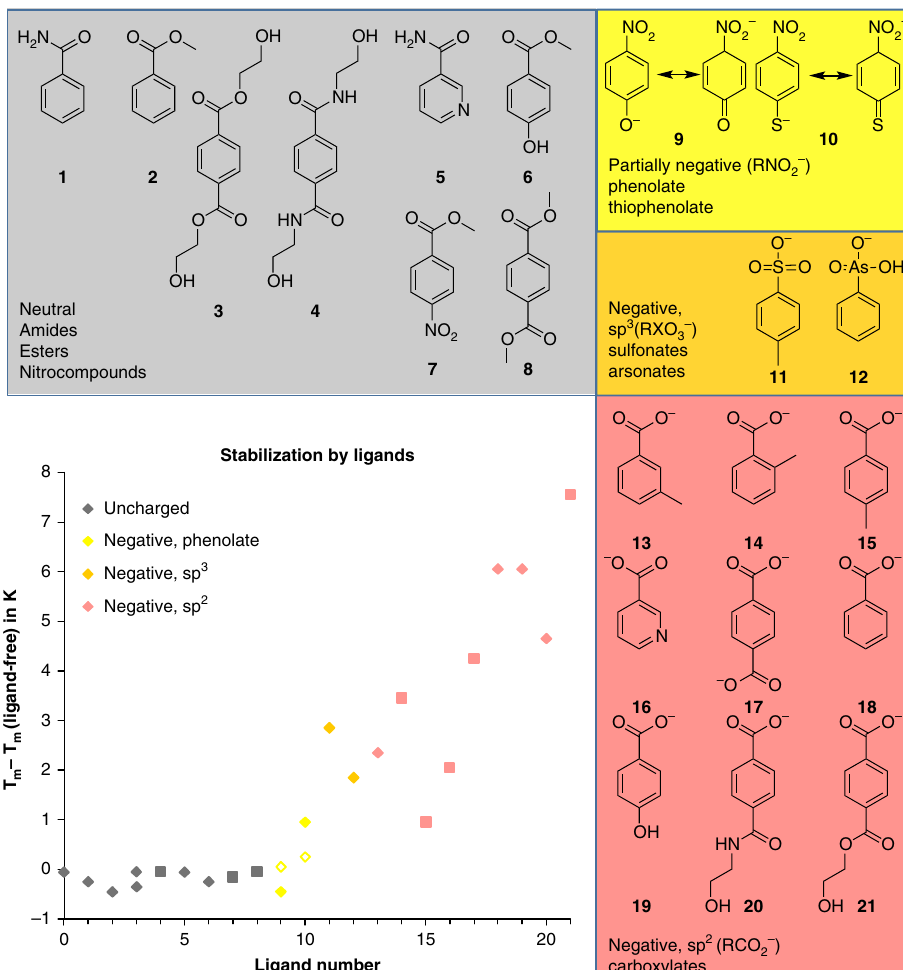
Fig. 3 Differential scanning fl uorimetry of MHETase with various ligands. Stabilization of MHETase wild type as measured by an increase in the melting temperature ( T m ) compared to the ligand-free protein ( T m, ligand-free ) is clearly dependent on the functional group, which binds to the rear of the substrate-binding site. Neutral functional groups (gray) affect T m weakest, partially negative groups (yellow) weakly, negatively charged groups more strongly, depending on their geometry: tetrahedrally coordinated medium (orange) and trigonal planar most strongly (red). Ligands diluted to 10 mM fi nal concentration (full diamonds). A saturated solution (with 43.5% DMSO) was diluted 2.2-fold, if the compounds did not fully dissolve (squares). For compounds hindering reliable measurements by absorption (4-nitrophenol, 4-nitrothiophenol, 2-hydroxybenzoic acid) or fl uorescence (BHET) 1 mM fi nal concentrations were used (empty diamonds). T m values are reported as provided by the Prometheus software (maximum of the slope for the I 330nm / I 350nm ratio). The experiment was performed as a single measurement. Ligand numbering is shown in Supplementary